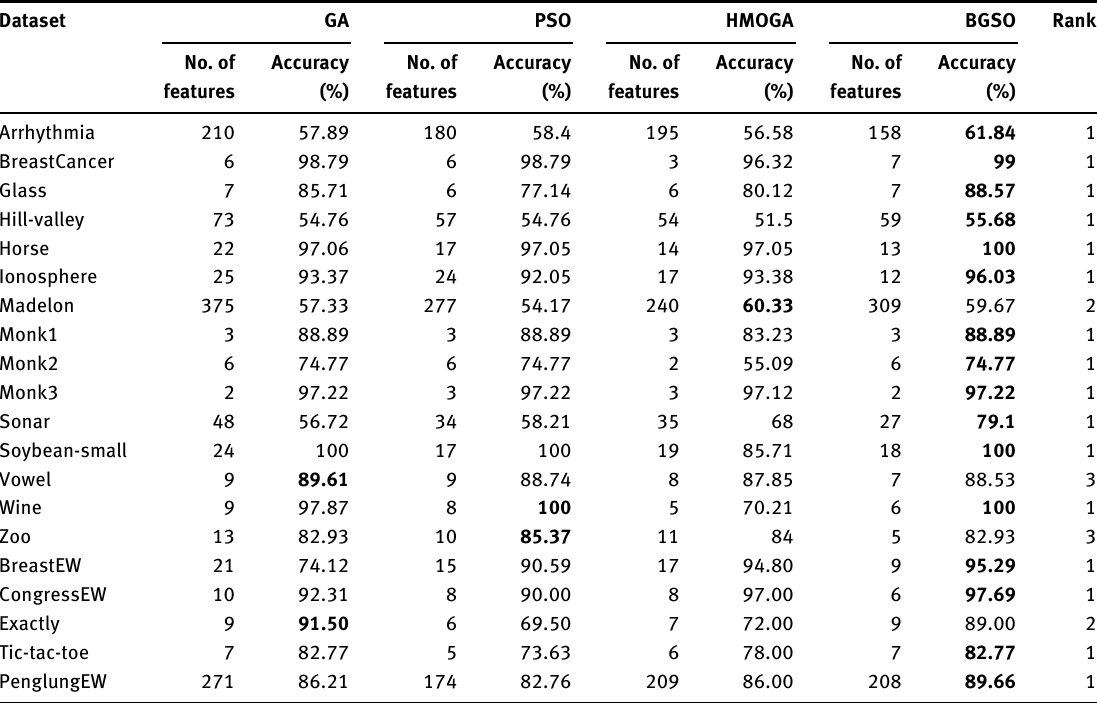
Table 3: Comparison of BGSO with Its Constituent Algorithms (GA and PSO) and HMOGA Using KNN Classifier. Dataset